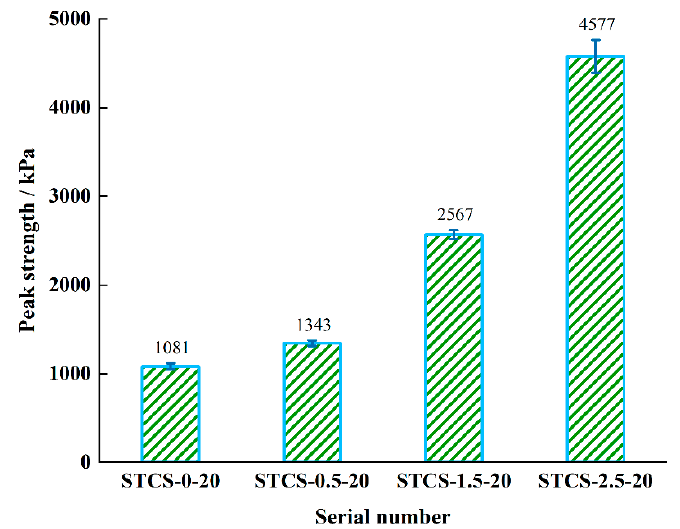
Crystals 2021 , 11 , x